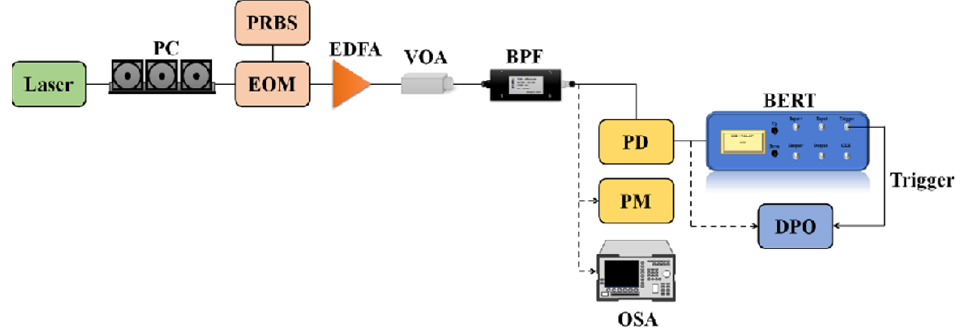
Figure 8. Experiment setup: PC: polarization Controller; EOM: electro-optic modulator; EDFA: er- bium-doped fiber amplifier; VOA: variable optical attenuator; PRBS: pseudo random binary se-